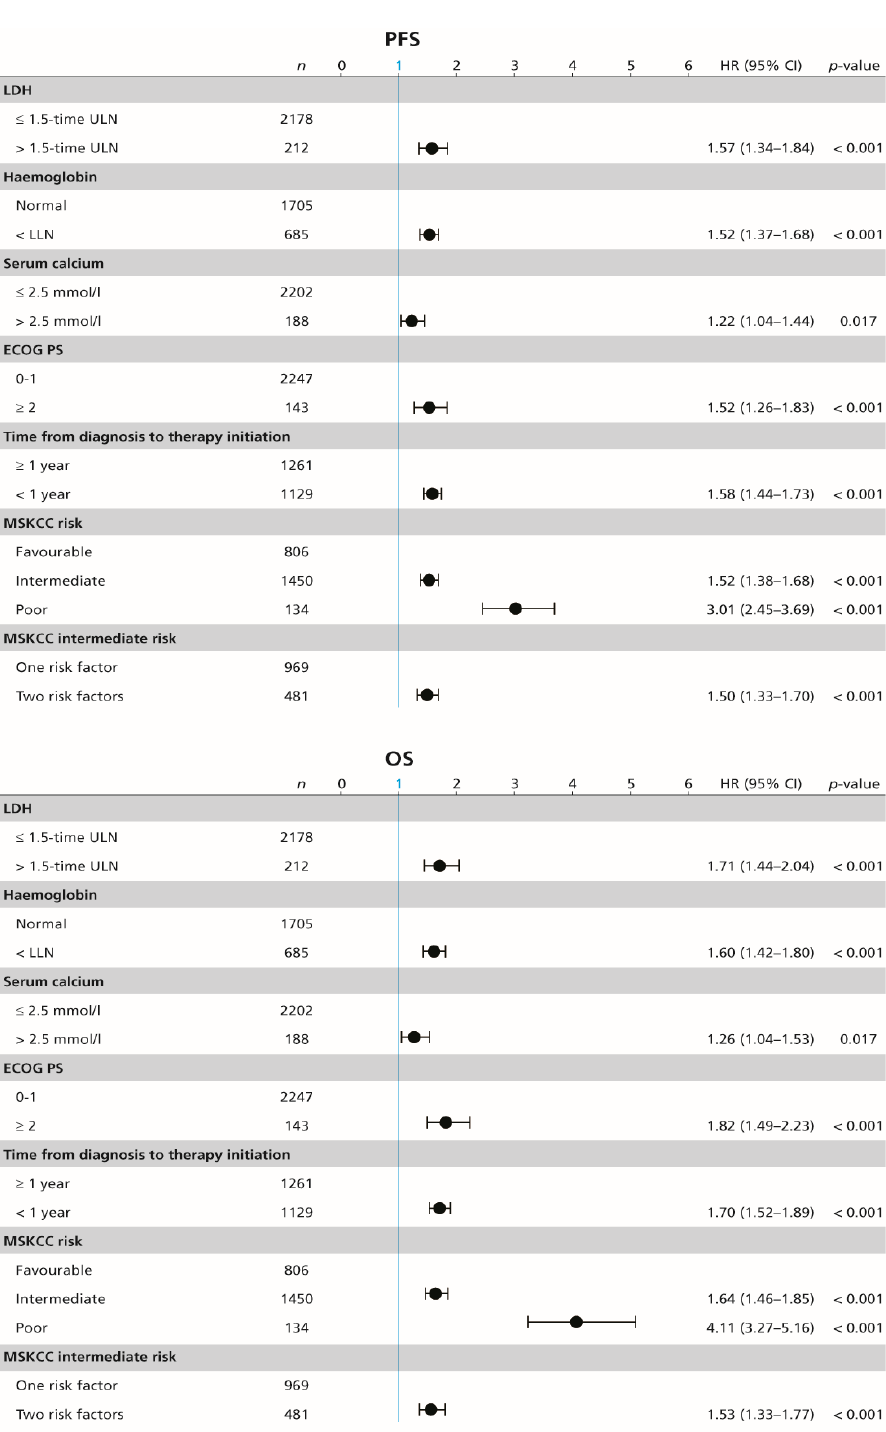
Figure 2. Forest plot (univariable Cox proportional-hazard regression model) showing the association between survival and MSKCC risk factors. MSKCC = Memorial Sloan–Kettering Cancer Center (MSKCC) score, PFS = progression-free survival, OS = overall survival, n = number of included patients, ECOG PS = Eastern Cooperative Oncology Group performance status, ULN = upper limit of normal, LDH = lactate dehydrogenase, HR = hazard ratio, CI = confidence interval.